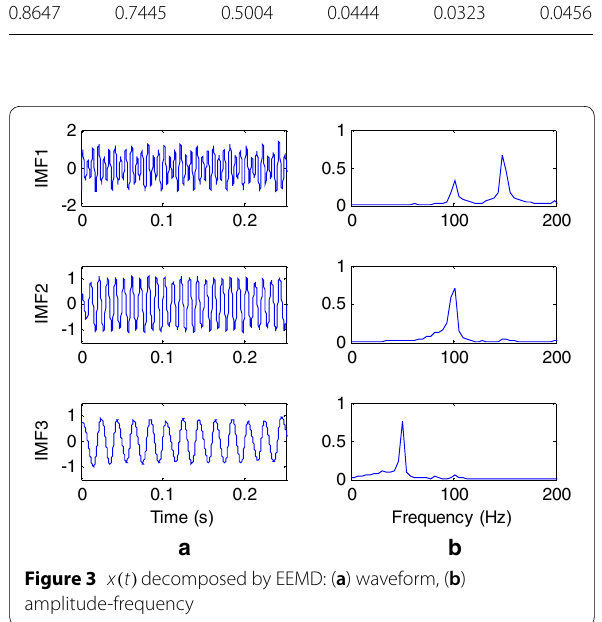
Figure 3 x ( t ) decomposed by EEMD: ( a ) waveform, ( b ) amplitude-frequency